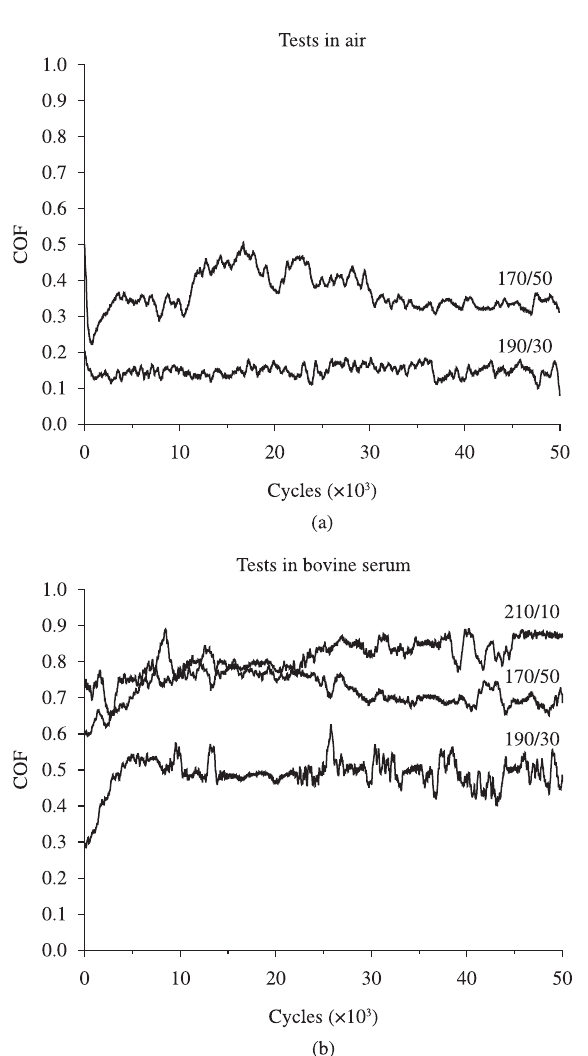
Figure 4. Variation of coefficient of friction (COF) and penetration depth of the Ti-doped carbon films submitted to scratch tests under rising loads up to 5 mN. Figure 5. Variation of coefficient of friction (COF) of produced coatings from Coatings were prepared with different (Ar/CH ) mass flows (in sccm). A total wear tests carried out by using pin-on-disk apparatus (a) in air; and (b) in 4 of 5 scratches were performed on each sample. Lines are guides to the eyes. liquid. Coatings deposited with different Ar/CH